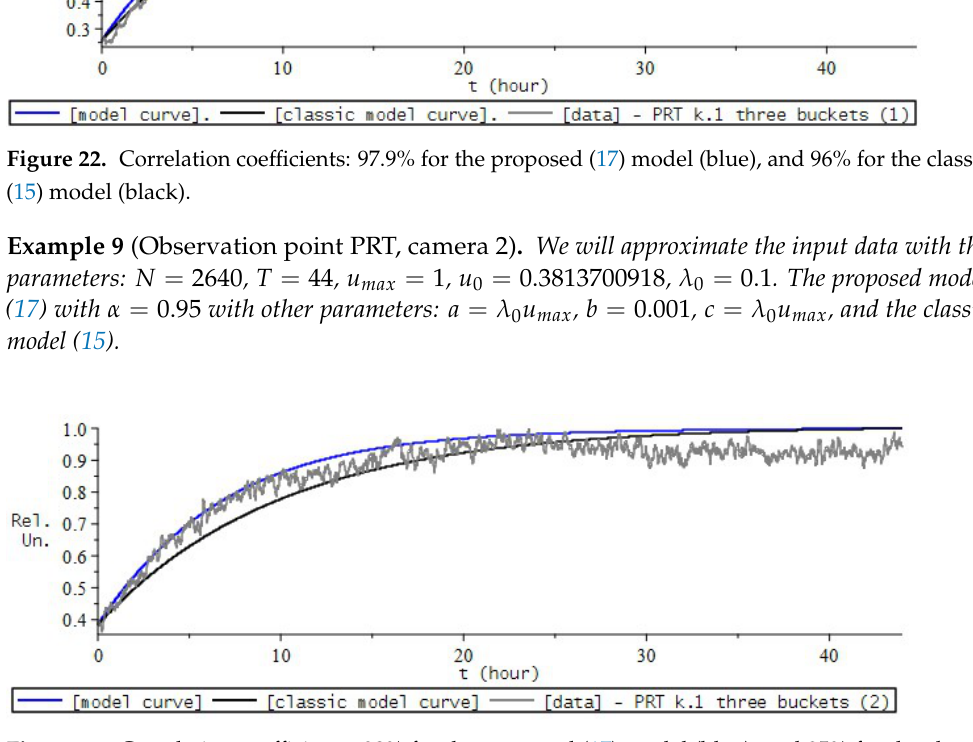
Figure 23. Correlation coefficients: 98% for the proposed (17) model (blue), and 95% for the classic (15) model (black).